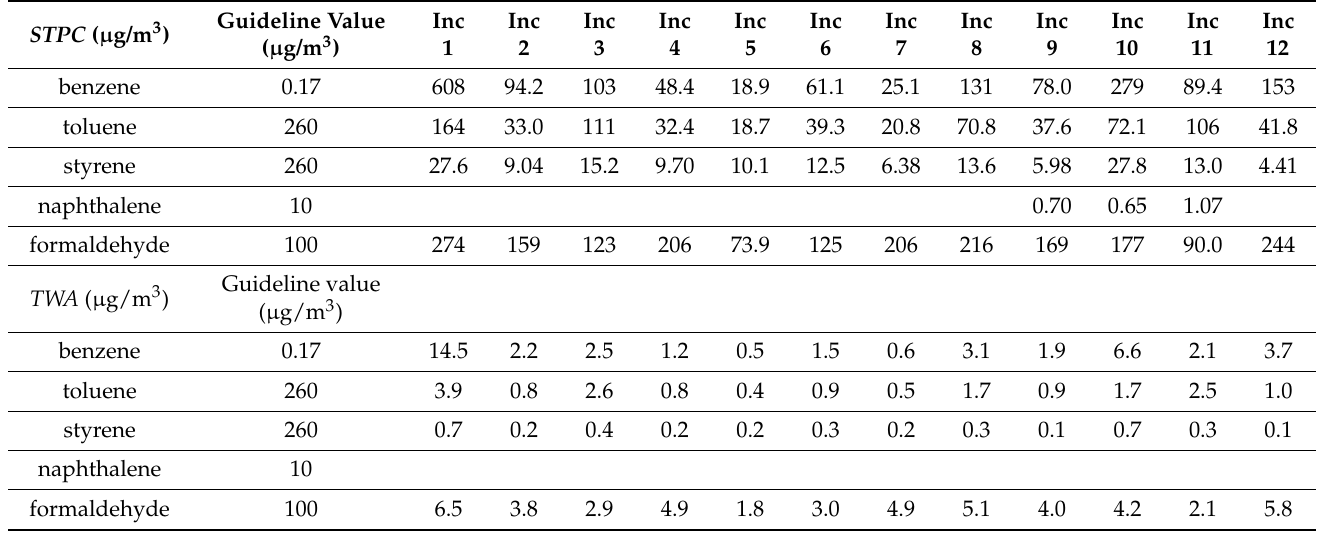
Table 7. Average values of STPC (short-term peak concentration) ( µ g/m 3 ) and TWA (worst-case time-weighted average) ( µ g/m 3 ) of VOCs with guideline values for the twelve products tested. STPC ( µ g/m 3